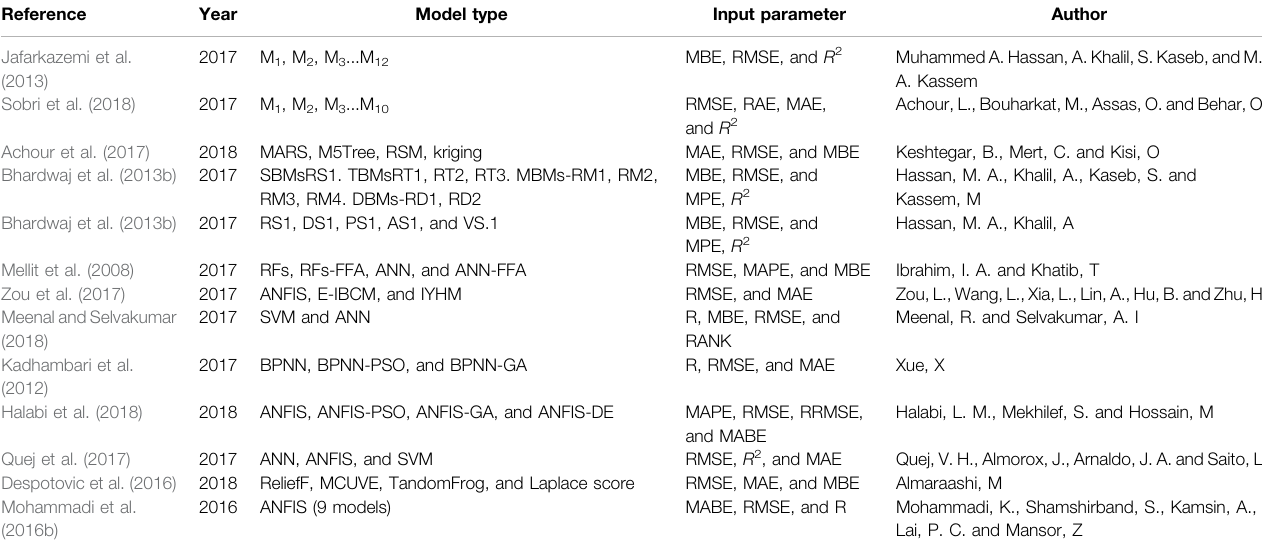
TABLE 10 | Different models of solar radiation forecasting from the latest literature